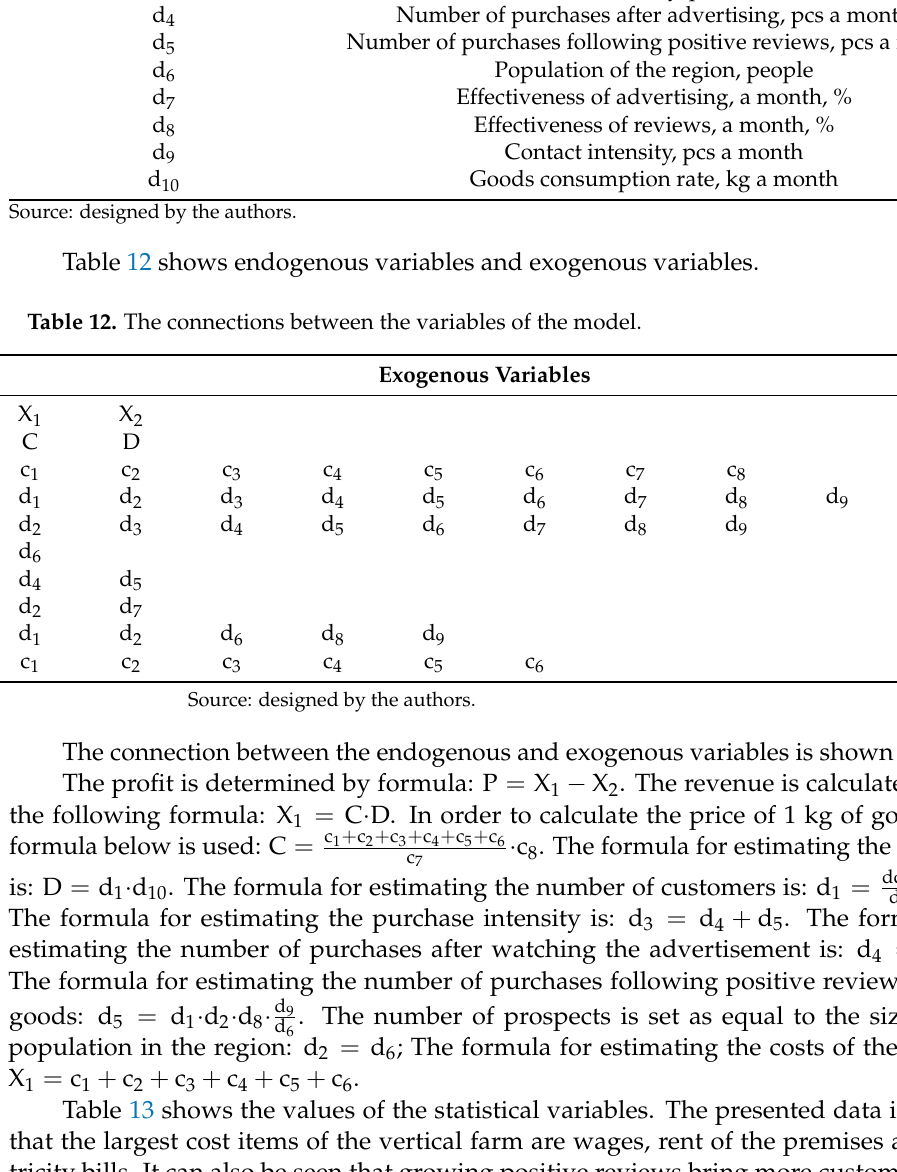
Table 11. List of factors affecting the demand of the farm. Designation Factor d 1 Number of customers a month, people d 2 Number of prospects, people d 3 Purchase intensity, pcs a month d 4 Number of purchases after advertising, pcs a month d 5 Number of purchases following positive reviews, pcs a month d 6 Population of the region, people d 7 Effectiveness of advertising, a month, % d 8 Effectiveness of reviews, a month, % d 9 Contact intensity, pcs a month d 10 Goods consumption rate, kg a month